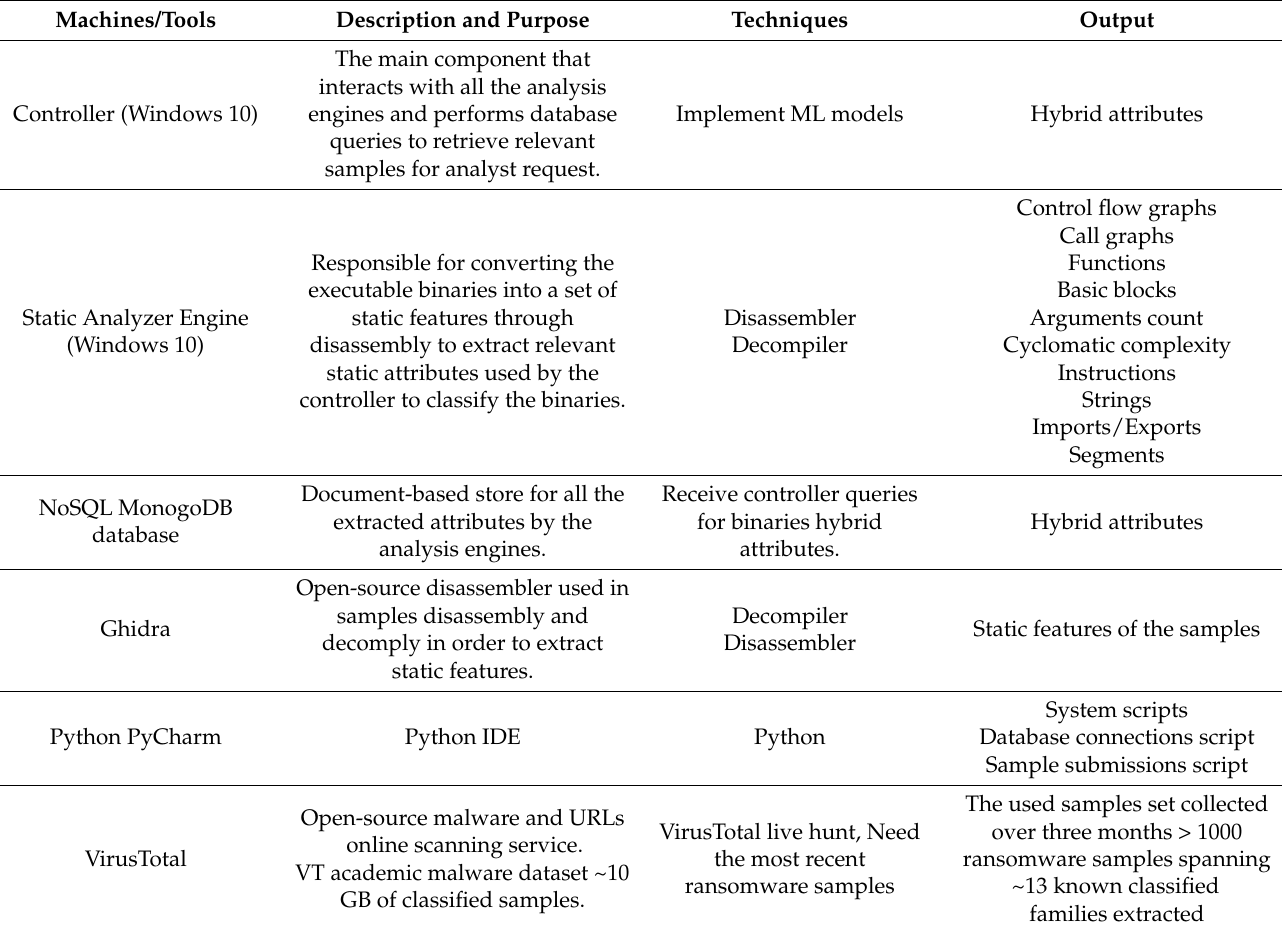
Table 7. Machines and Tools Used in Lab